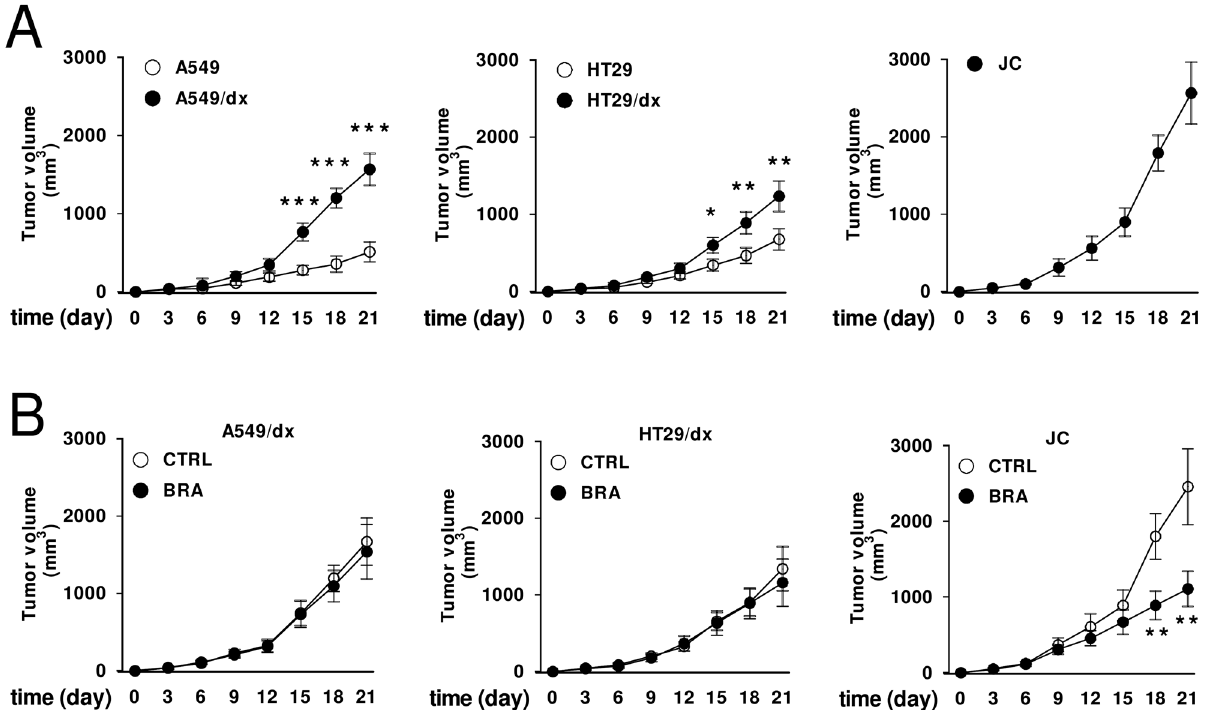
Fig 2. Effects of IDO1 inhibition on the growth of multidrug resistant tumors. A . 1 x 10 5 human A549, A549/dx, HT29, HT29/dx cells were implanted subcutaneously in 6 – 8 weeks old female nude BALB/c mice, 1 x 10 5 murine JC cells were implanted in immunocompetent BALB/c mice. Tumor growth was monitored daily by caliper measurement. Data are presented as means ± SD of 10 mice/group. * p < 0.02, ** p < 0.005, *** p < 0.001: A549/dx or HT29/dx cells versus A549 or HT29 cells, at the corresponding time points. B . Animals bearing A549/dx-, HT29/dx-, JC-tumors were randomized into two groups when tumors reached the volume of 100 mm 3 : “ Control ” group (treated with 100 μ L of saline solution per os , 5 days/week for three weeks; CTRL); “ Brassinin ” group (treated with 400 mg/kg of the IDO1 inhibitor 5-Br-brassinin per os , 5 days/week for three weeks; BRA). Tumor growth was monitored daily by caliper measurement. Data are presented as means ± SD of 6 mice/group. ** p < 0.005: BRA-group versus CTRL-group, at the corresponding time points.